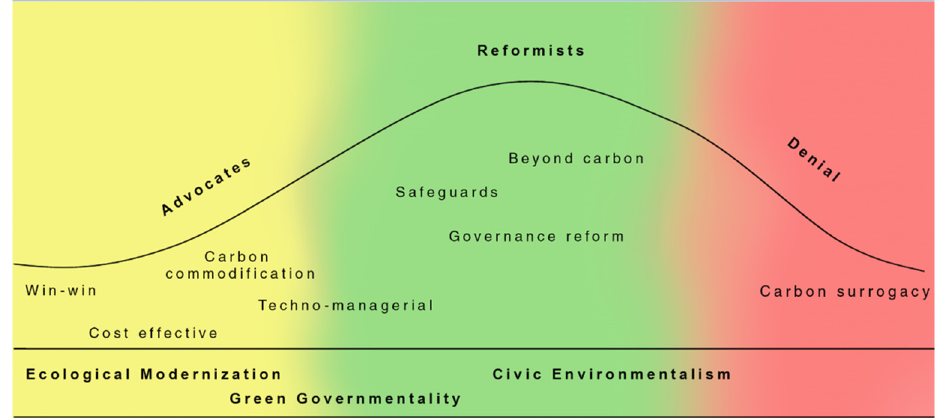
Figure 3. Major REDD+ storylines and policy discourses in Nepal’s REDD+ policy arena. (Source: Authors’ own illustration).